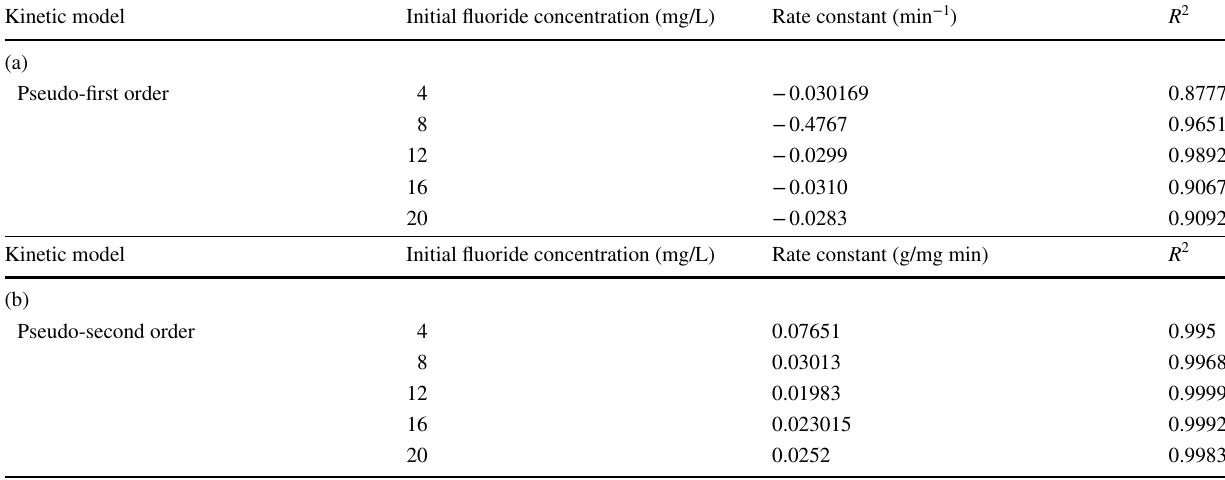
Table 4 Kinetic parameters: (a) pseudo-first-order and (b) pseudo-second-order kinetic parameters Kinetic